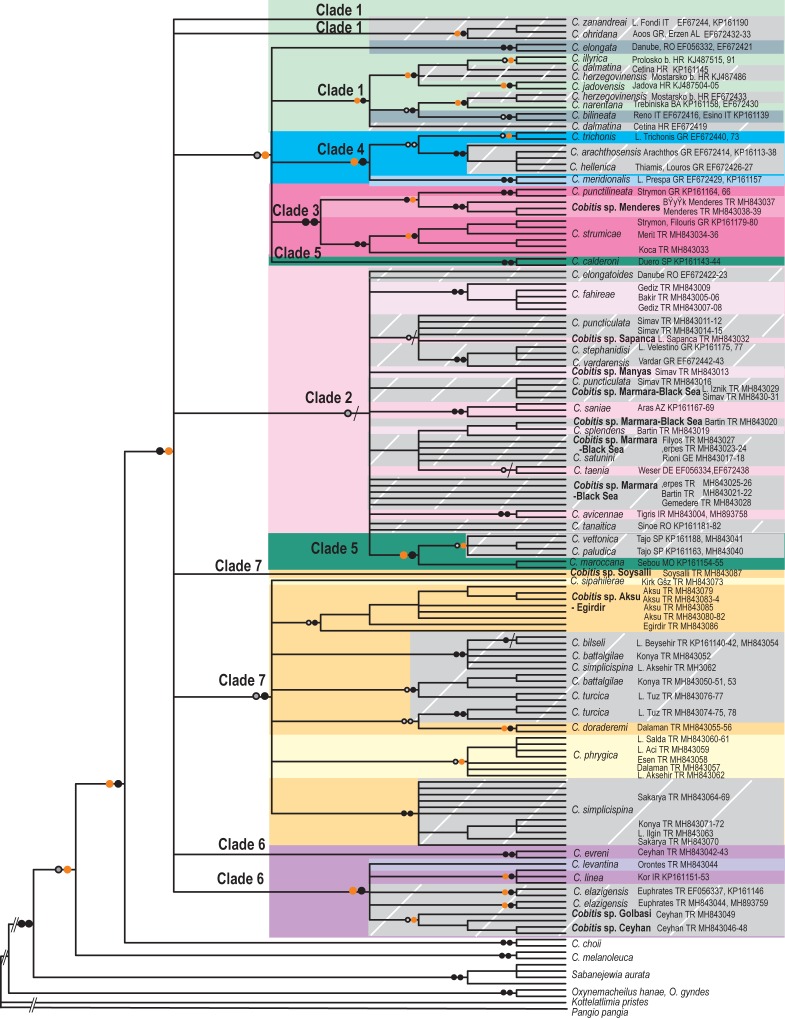
Phylogenetic tree for for Western Palearctic Cobitis based on the RAG1 dataset (N = 158).Symbols on branches correspond to bootstrap values (BT) for RAxML and Bayesian posterior probability support (pp), respectively: Black dots >95 BT/pp, orange dots 85–95 BT/pp, grey dots <85–50 BT/pp, / No support. The seven major clades (Clades 1–7) obtained in the mtDNA analysis are indicated in the RAG1 phylogeny with similar colour as shown in Fig 1. Species of each major clade are identified with darker to lighter shades of the corresponding clade colour. Species not recovered as monophyletic are indicated with grey boxes with bars.